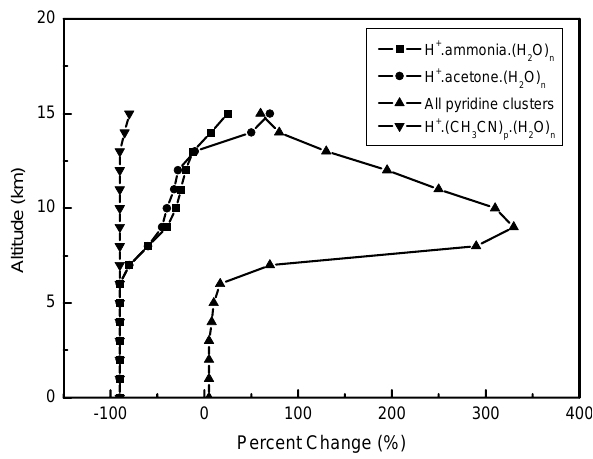
Fig. 4. Percentage change in major tropospheric positive ion com- position for the scenario where concentration of all neutral com- pounds is increased by an arbitrary factor 10 from the background